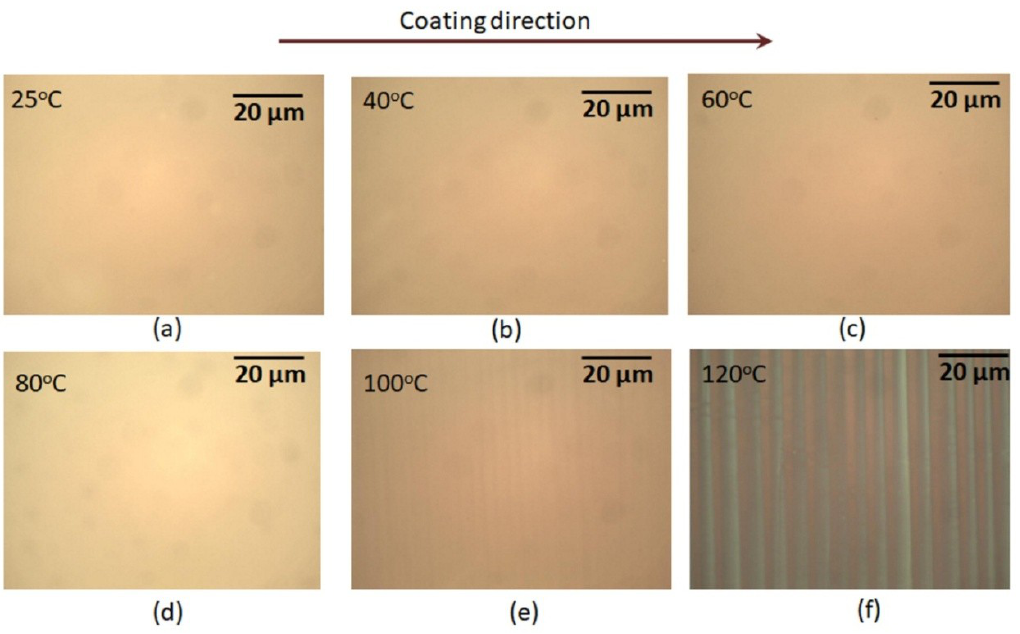
Figure 3. Optical image of slot-die coated PEDOT:PSS film deposited at different temperatures. The coating speed and flow rate were kept constant at 1 mm/s and 1 μL/s, respectively.